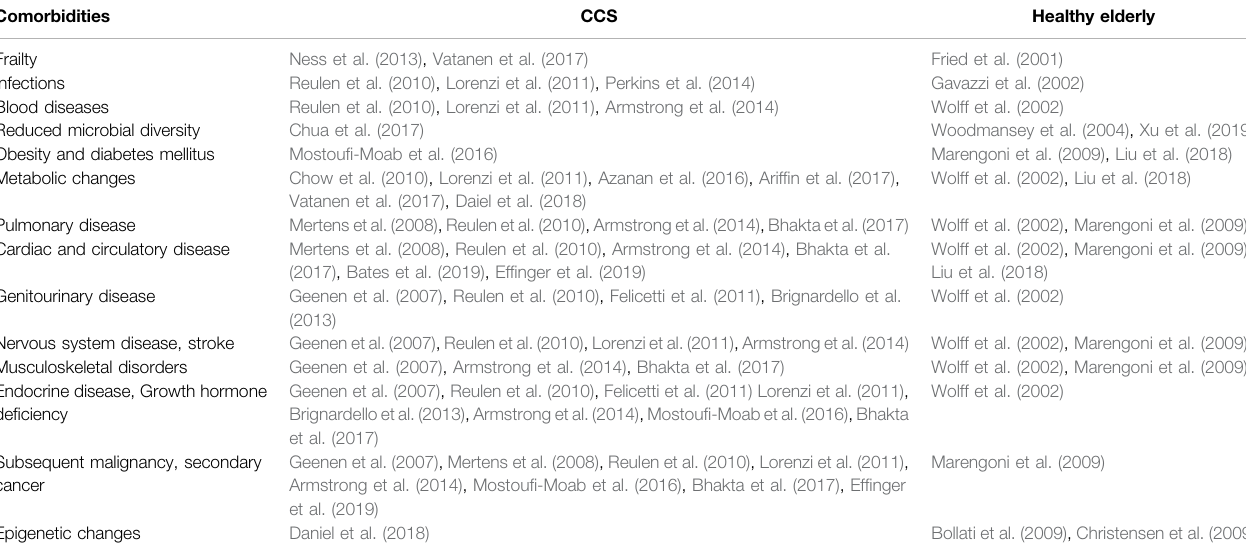
TABLE 1 | Adverse health conditions associated with accelerated senescence in CCS and the elderly. Comorbidities CCS Healthy elderly Frailty Ness et al. (2013), Vatanen et al. (2017) Fried et al. (2001) Infections